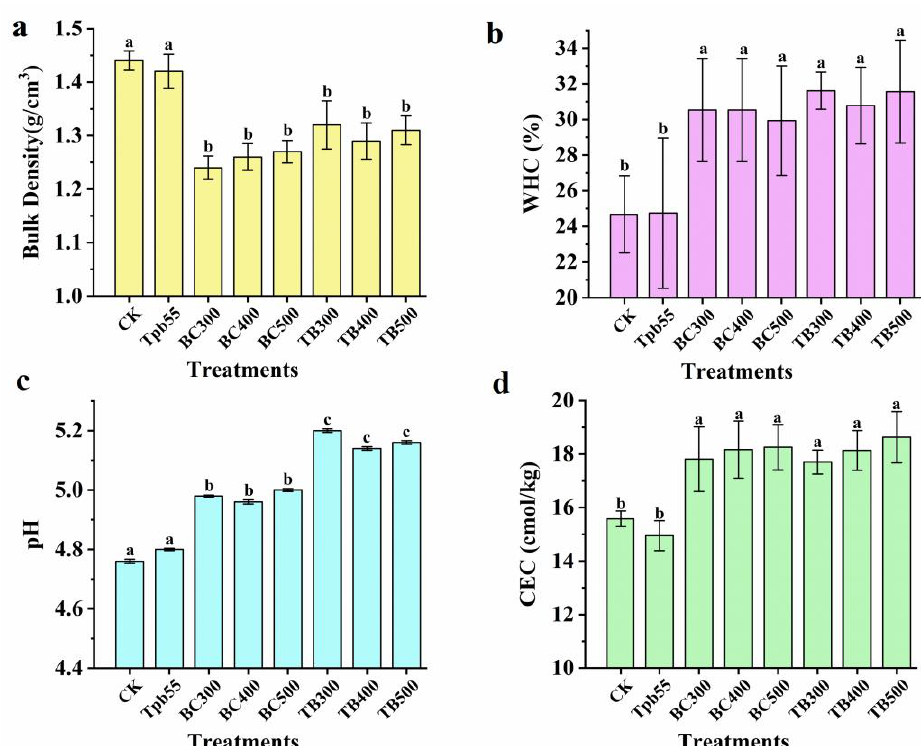
Figure 4. Influences of different treatments of biochar and Tpb55 on ( a ) bulk density, ( b ) water- holding capacity (WHC), ( c ) pH, and ( d ) cation exchange capacity (CEC) of soil; bars with the different letters show significant differences (LNK method, p < 0.05). Table 3. Effects of different treatments on the available nutrients of soil.